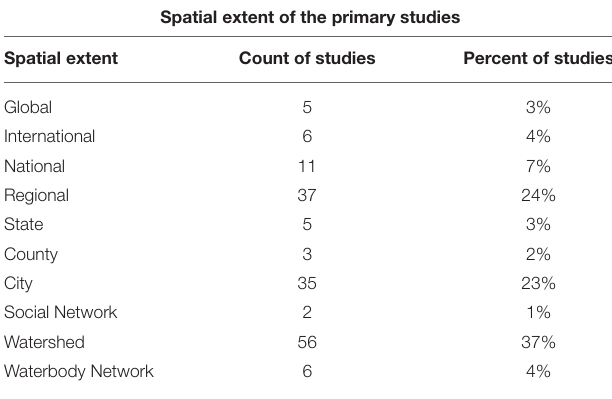
TABLE 8 | Spatial extent identified for the primary studies.